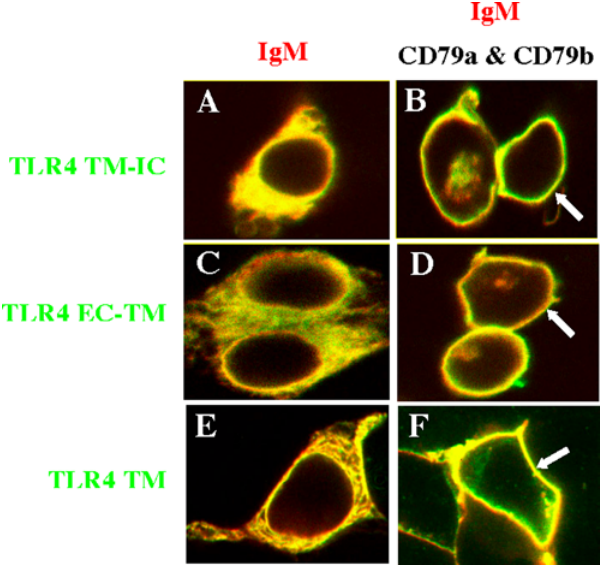
Figure 6. TLR4/BCR associate through the TLR4 transmem- brane region. HEK293 cells were co-transfected with truncated or full length TLR4 constructs with BCR ( left panel ) or BCR + CD79a/CD79b ( right panel ). Cells were prepared as in Figure 5 and all panels represent the overlay of green (anti-HA staining) and red (anti-IgM staining) channels. The HA-tagged TLR4 TM-IC construct (A–B), TLR4 TM-EC construct (C– D), as well as the TLR4 TM region alone (E–F) each translocated to the cell surface with expression of surface IgM.